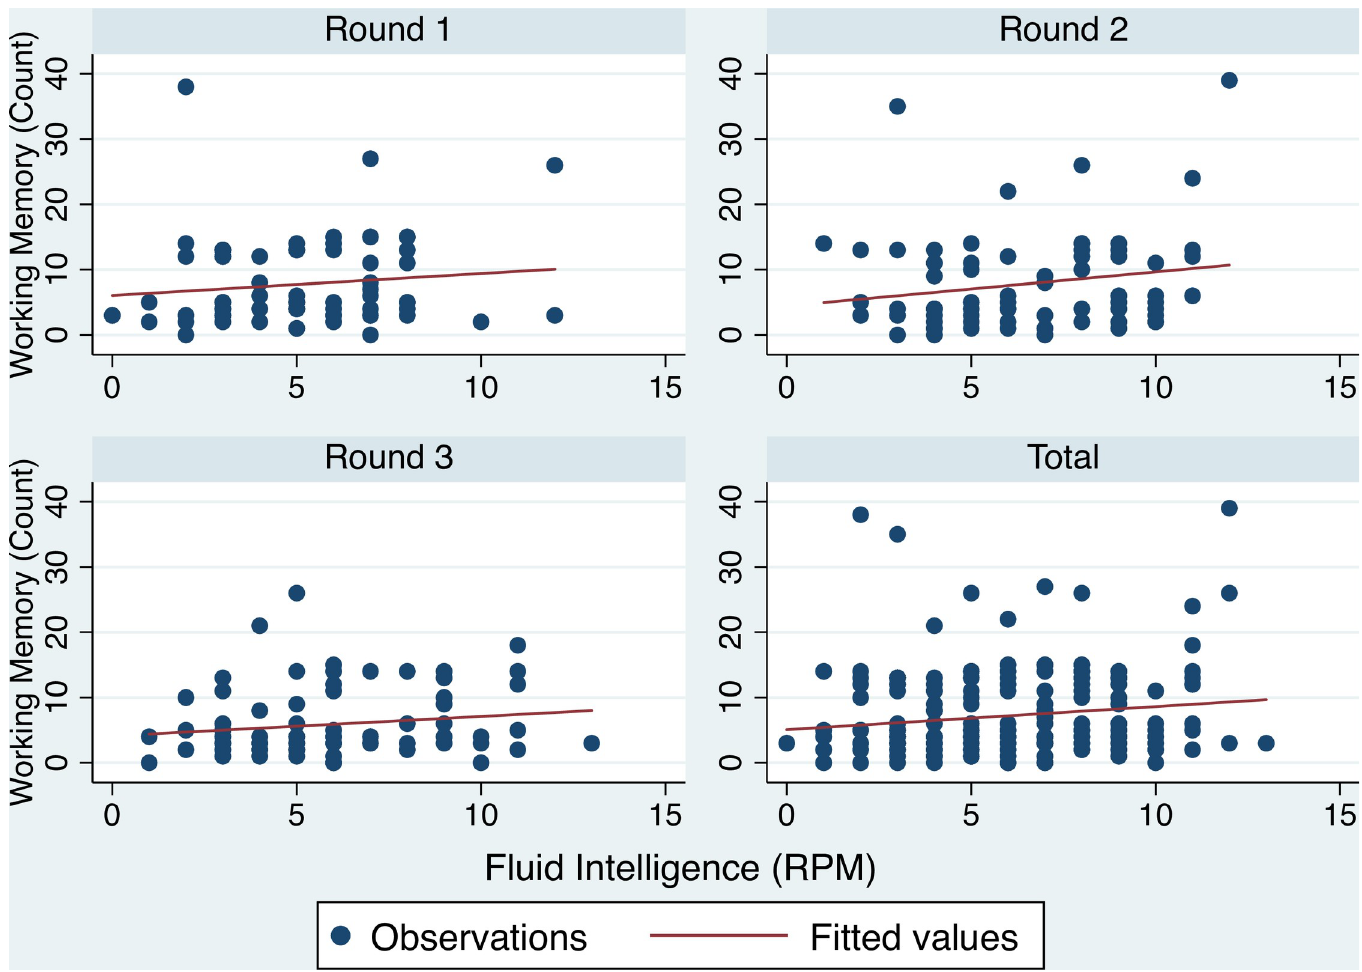
Fig 1. Count and RPM scores by round. Scatter plot of Count and RPM scores by survey round.